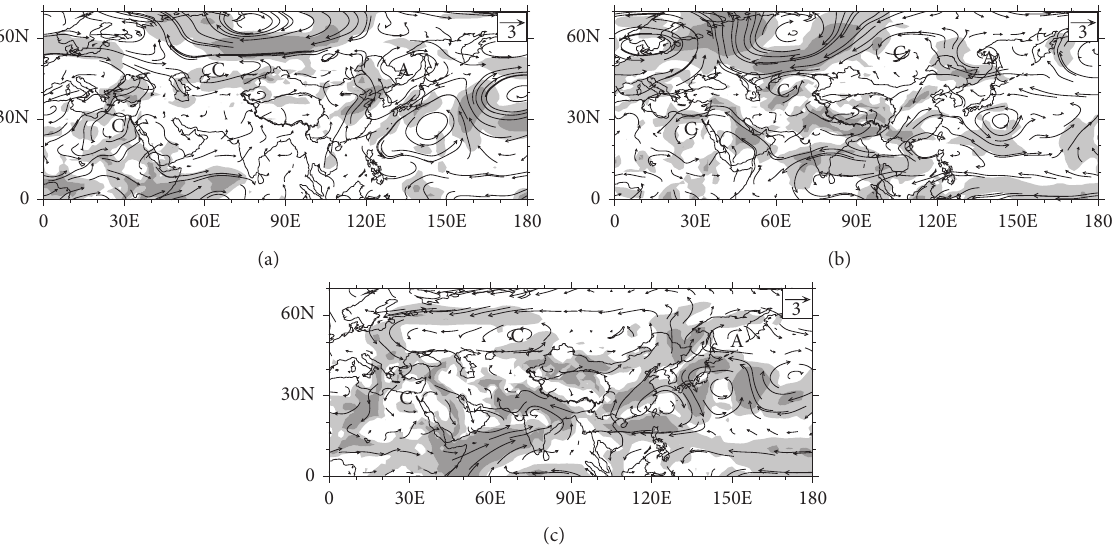
Figure 4: (a) Regression maps of 850hPa wind (vectors, units: m · s − 1 ) anomalies against (a) NCR, (b) TPR, and (c) ISR for JA during 1979–2007. Dark (light) shadings indicate values significantly exceeding the 99% (90%) confidence level using Student’s t